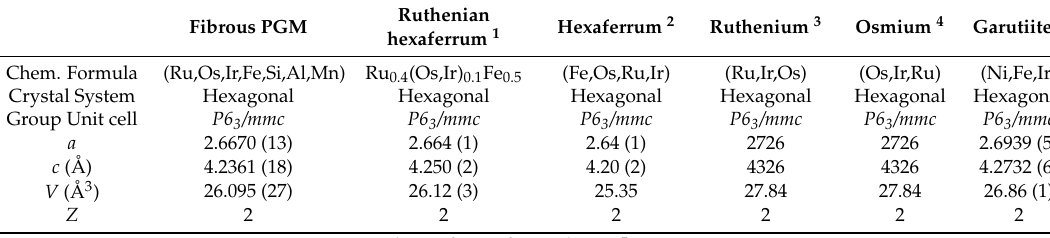
Table 2. Comparative data for chemically related phases including the fibrous